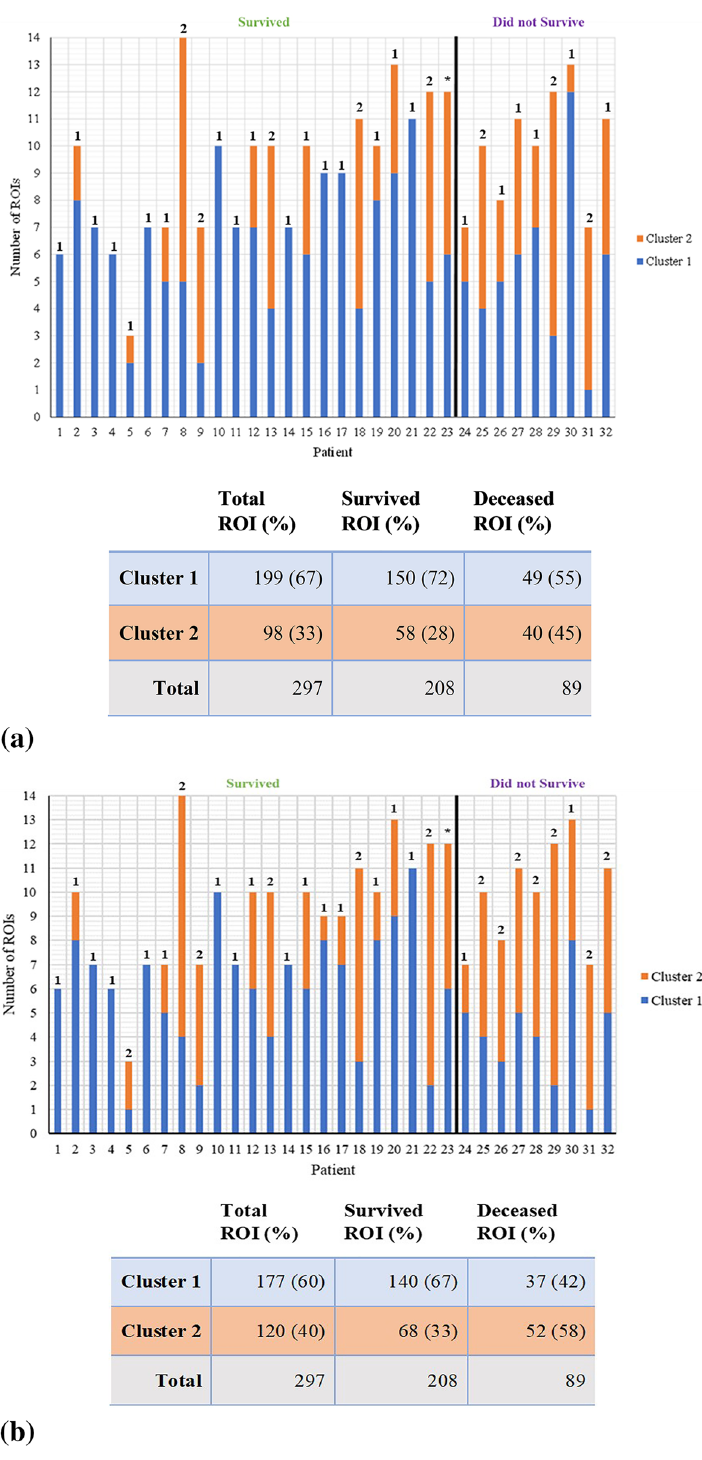
Figure 3. Resultant cluster assignments (blue = Cluster 1, orange = Cluster 2) of each region (n = 297) across all 32 patients for ( a ) K-means model, ( b ) Fuzzy C-means, ( c ) Gaussian Mixture Model. The black line partitions those who survived from those that did not. The number above each bar indicates the overall cluster assignment for that patient based on the majority-vote approach; the ambiguous “perfect tie” patients (*) remained unassigned (for details, see text). The table summarizes the assignment data for all 297